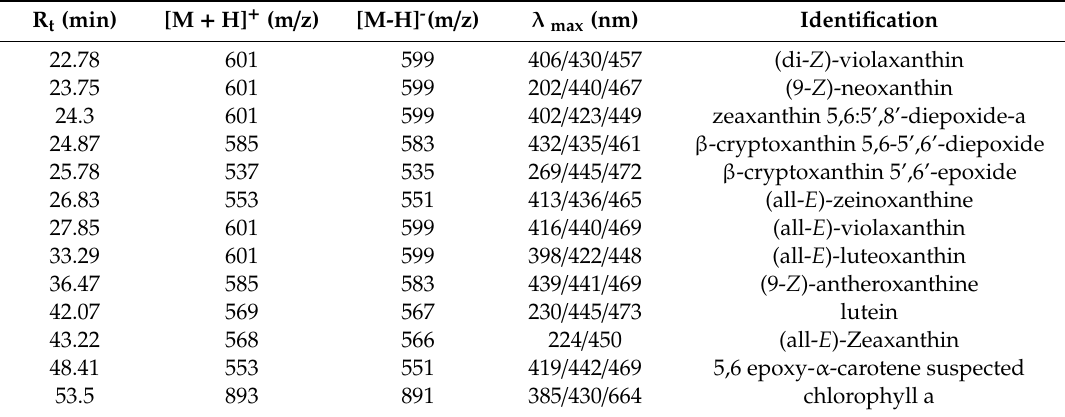
Table 2. Peak assignment of Scenedesmus sp. extract stressed by 10 g / L of NaCl (Ss10), acquired by